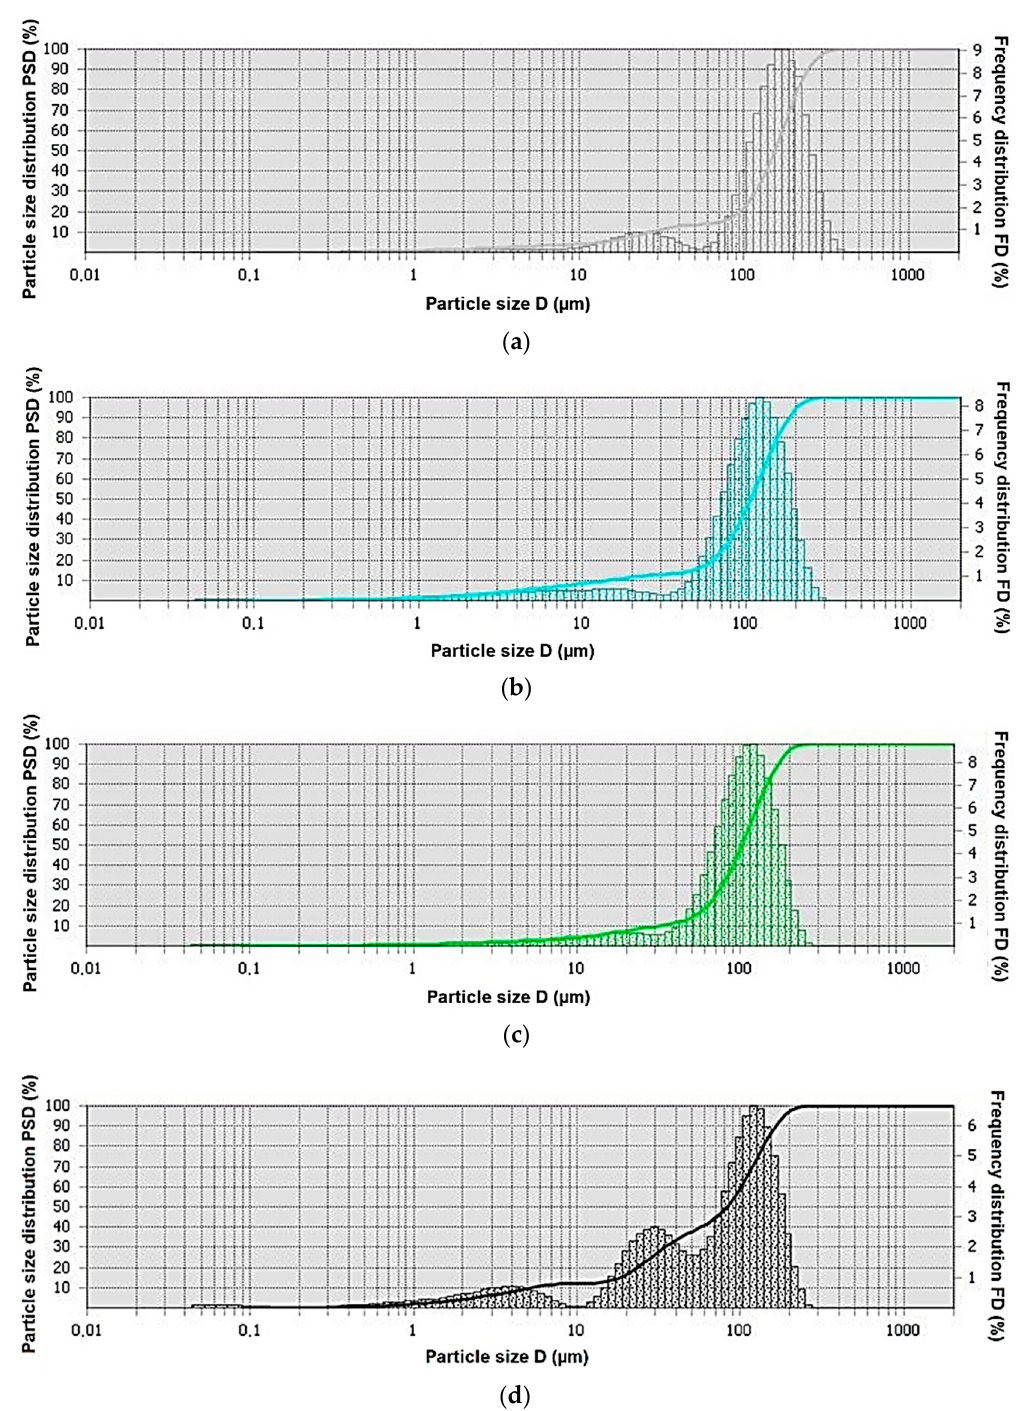
Figure 4. Graphs of cumulative percent passing versus the logarithmic particle size: ( a ) C1 filler material; ( b ) C2 filler material; ( c ) C3 filler material; ( d ) C4 filler material. Table 6. Statistical mean values of the particle size distribution of the powders used for surfacing (PPTAW) of composite layers.